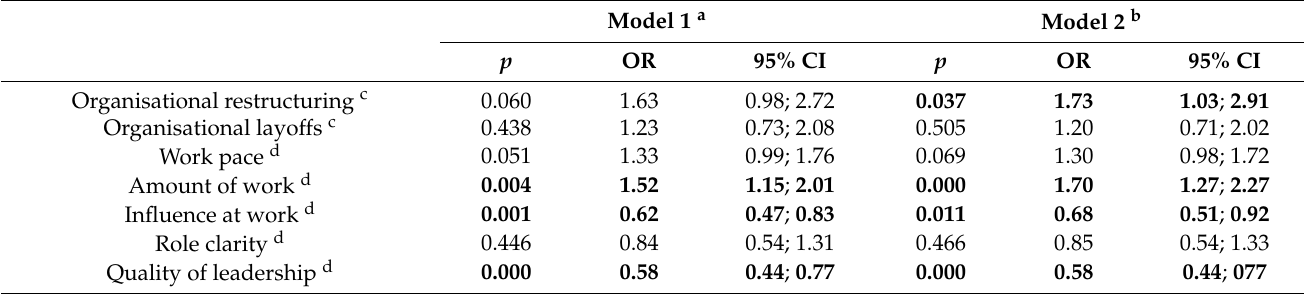
Table 4. Associations between working conditions at baseline and workplace bullying at follow-up among employees not bullied at baseline ( N =